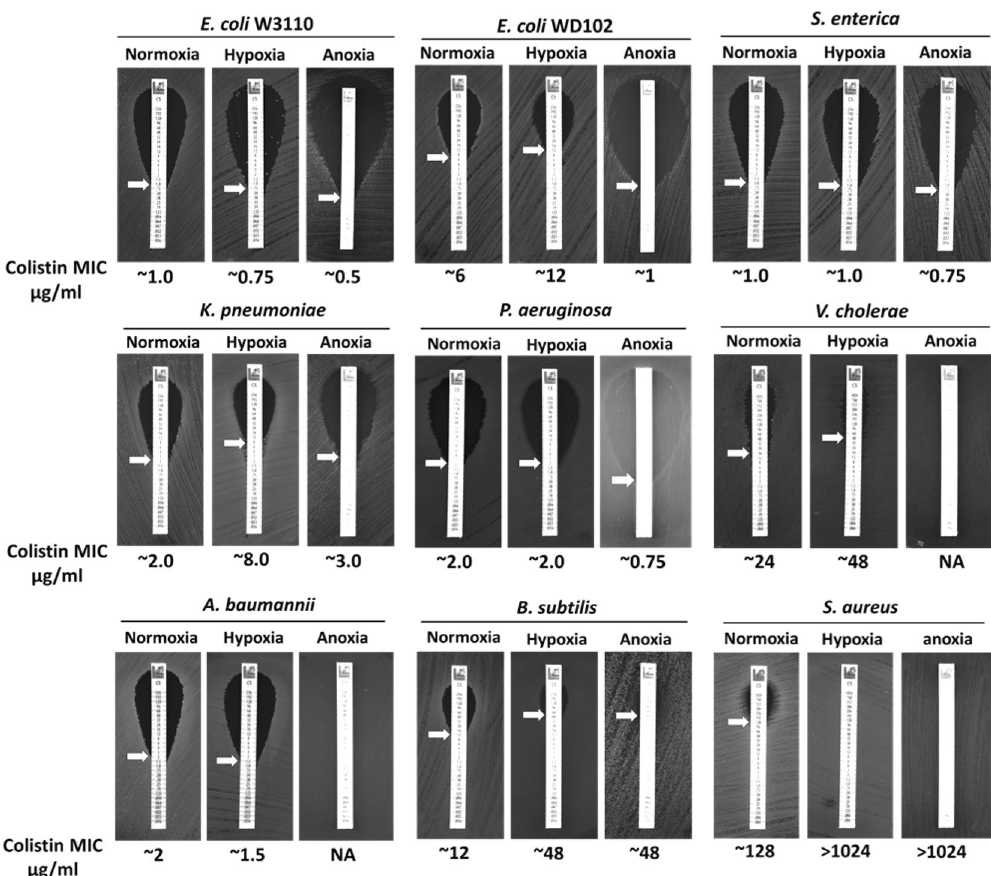
Figure 5. Oxygen dependent colistin resistance in different bacterial species. The colistin MIC was determined for indicated strains on LB agar plates. For anoxia, LB agar plates were supplemented with 20 mM sodium nitrate. Plates were analyzed after 24 h of growth at 37 °C. Approximate MICs are denoted by white